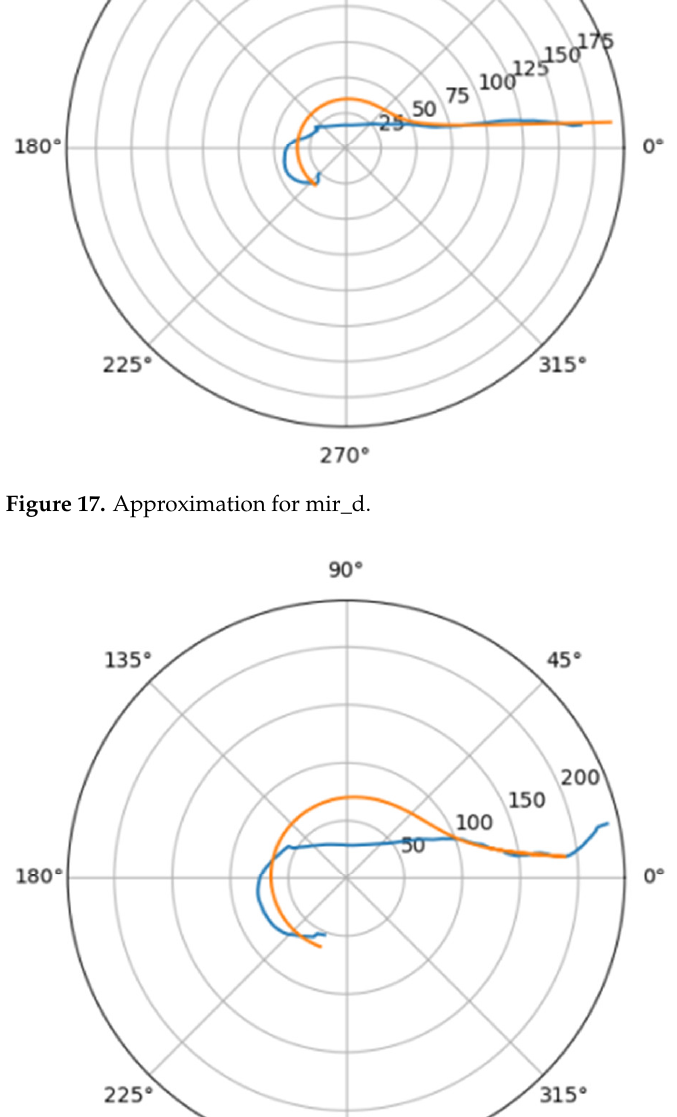
Figure 18. Approximations for gor_d.